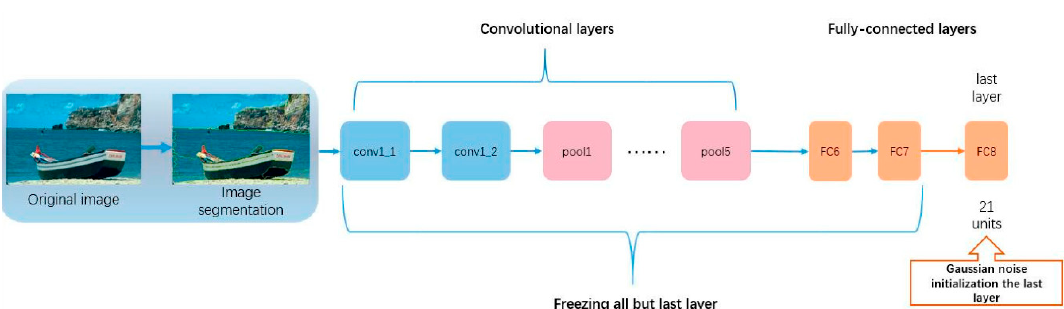
Figure 6. This paper convolutional neural networks (CNN) model. Since our data set is small and similar to ImageNet, we used the method of freezing and training the last layer for transferring learning. The pre-trained network inner layer parameters (conv1-FC7) were transferred to the target classified by the PASCAL VOC object. For fine-scaled image edges and details, we initialized the last layer with Gaussian noise.